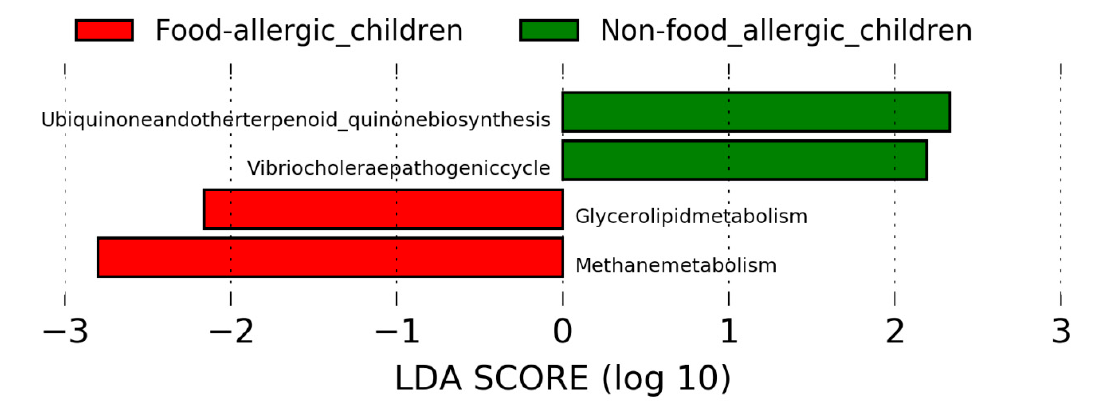
Figure 3. Linear discriminant analysis effect size (LEfSe) analysis revealed distinct KEGG pathway differences in gut microbiota between food-allergic children and non-food allergic children. KEGG pathway enriched in food-allergic children was indicated with red while the KEGG pathway enriched in non-food allergic children was indicated with green. Only the taxa that met a LDA significant threshold of >2 are displayed. LEfSe: Linear discriminant analysis effect size. LDA: Linear discriminant analysis. KEGG: Kyoto Encyclopedia of Genes and Genomes.